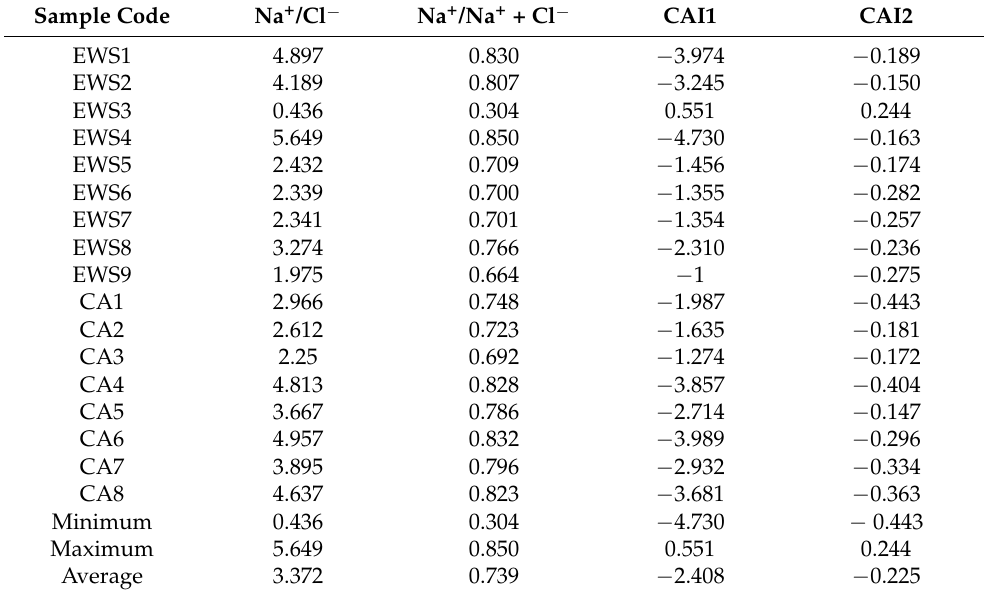
Table 4. Computed values of Na + /Cl − and Na + /Na + + Cl − ratios and chloro-alkaline indices for the analyzed groundwater in the Gumselasa